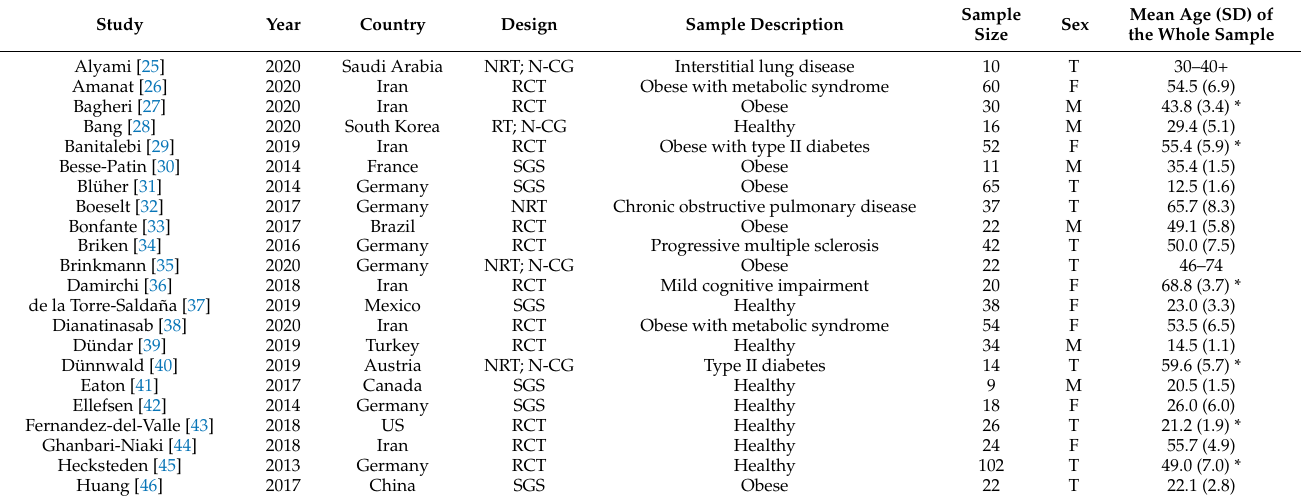
Figure 1. Flowchart illustrating the different phases of the search and study selection. Table 2. Studies included in this systematic